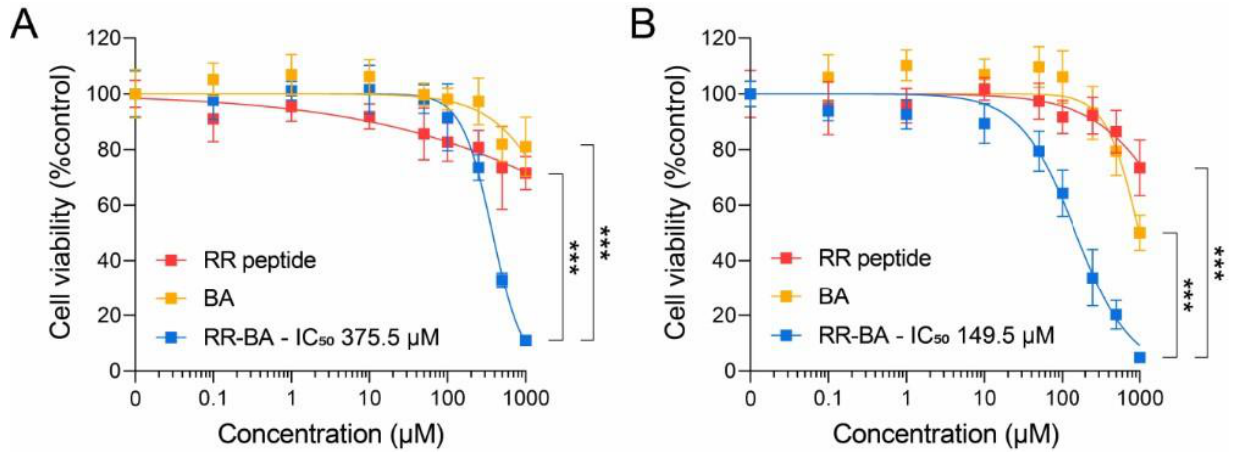
Figure 6. Cell viability and corresponding IC50 values of CT26 tumor cells in the concentration range of 0.1–1000 µM RR–BA, RR peptides, or BA were measured after 24 h ( A ) and 48 h ( B ) incu- bation. The 24 h cytotoxicity IC50 value of RR peptide and BA is NA and RR–BA is 375.5 µM ( A ). The 48 h cytotoxicity IC50 value of RR peptide and BA is NA and RR–BA is 149.5 µM ( B ). *** Denotes statistically significant differences in a comparison of RR–BA with RR peptides and BA (*** p < 0.001). Results represent means ± S.D.